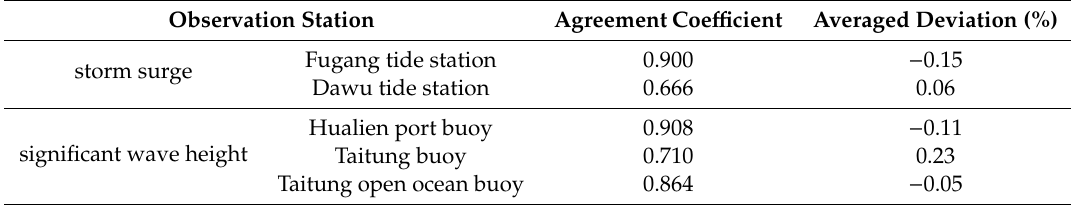
Table 2. Statistical results of the quantitative verification in Typhoon